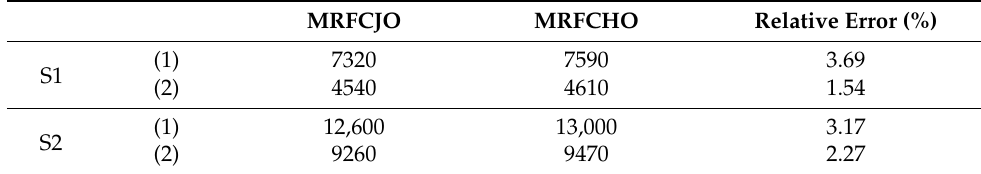
Table 4. Relative errors ( ε r ) of the peak discharge at the Lutaizi